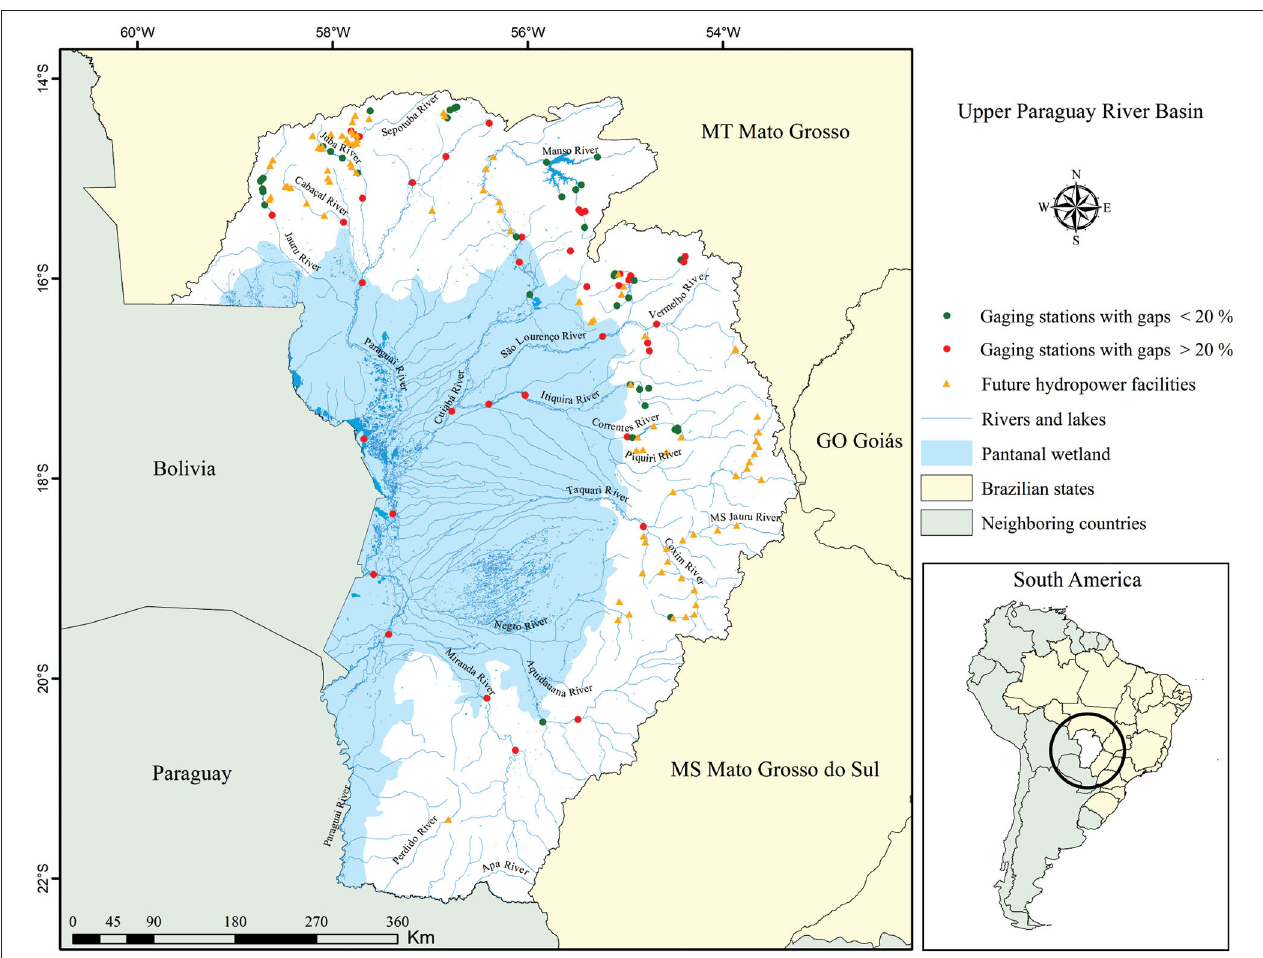
FIGURE 1 | Map of the Upper Paraguay River Basin showing the distribution of river gaging stations upstream and downstream of currently operating hydropower facilities, indicating the stations with data gaps of < 20% that allowed upstream-downstream comparisons for 24 hydropower facilities. The map also shows future hydropower projects that are either under construction, planned, or identified as potential sites for hydropower development in the Pantanal watershed by either the Brazilian National Electric Energy Agency (ANEEL) or the state environmental agencies (depending on